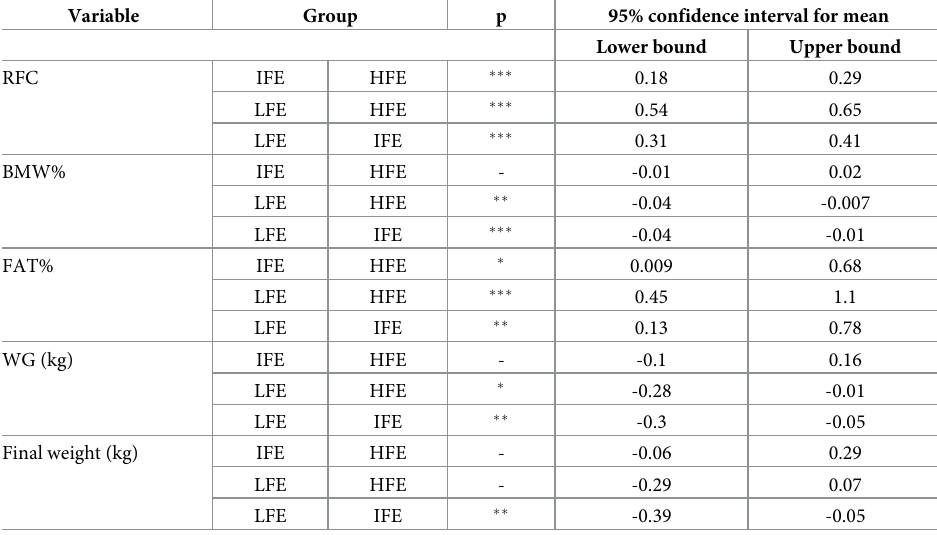
LFE: Low FE; HFE: High FE; IFE: Intermediate FE. Significance level: p-value < .05 � , < .01 �� , < .001 ��� , >